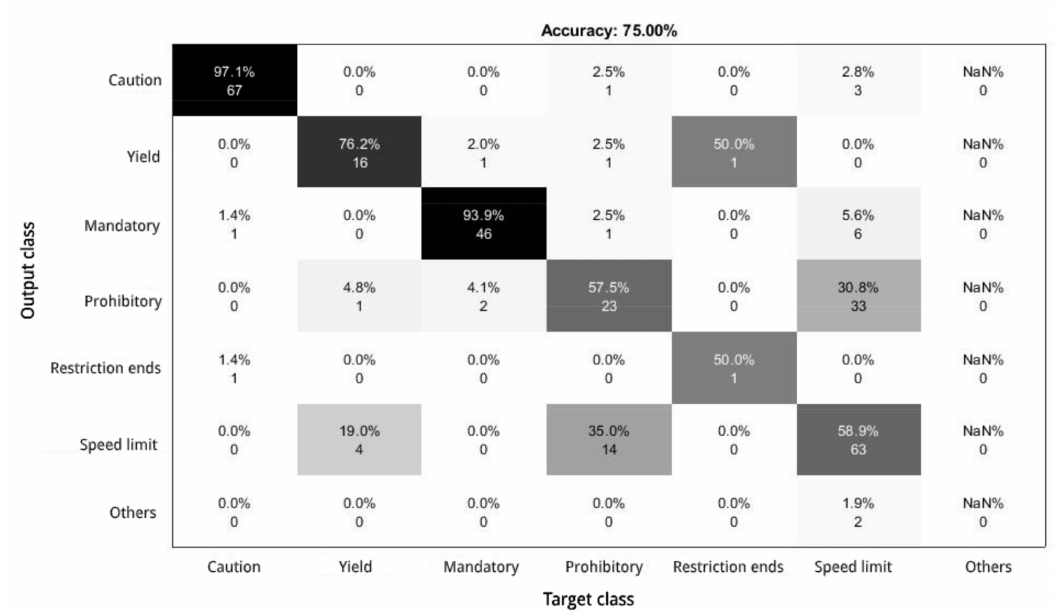
Figure 7. Confusion matrix of the final solution trained with the GTSB dataset and validated with the Ceit-TSR